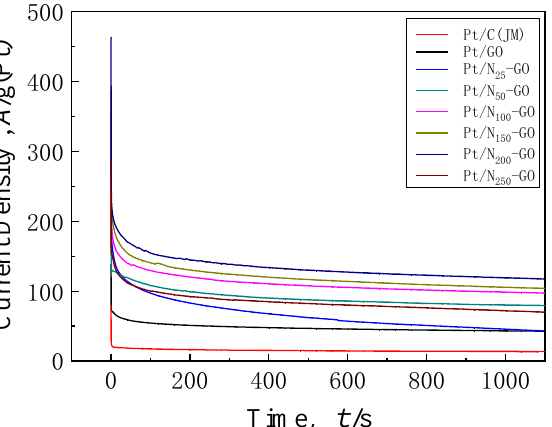
Figure 8. I – t curves recorded for the catalysts in a solution of 1 mol/L CH 3 CH 2 OH and 0.5 mol/L H 2 SO 4 .